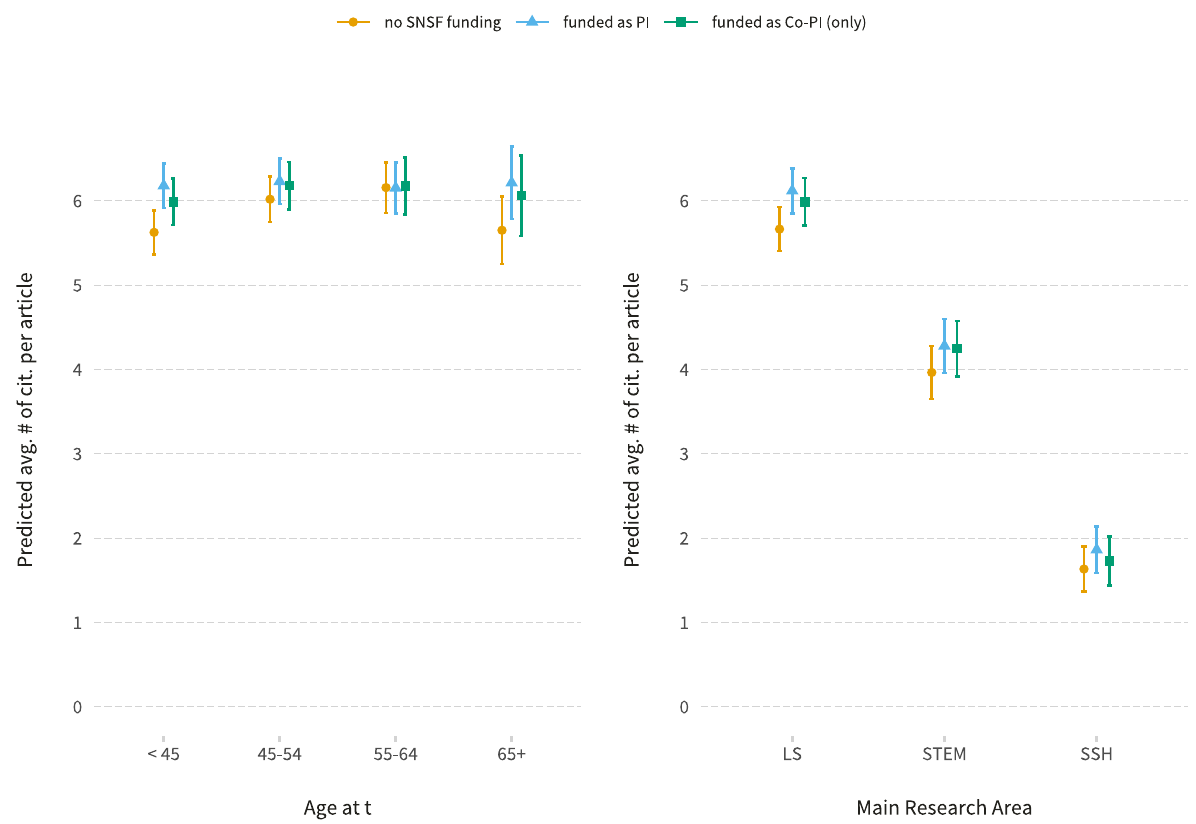
Fig. 3 Predicted yearly average number of citations per article depending on whether or not the researchers were treated or not, given the researcher ’ s age group (left) and the research fi eld (right). For the predictions the baseline confounding variables were fi xed to Year 2010 – 14, Male, Evaluation Score Score AB-A, University, LS in the age interaction model and age lower to 45 for the fi eld interaction model. A signi fi cant positive percentage change of 10% for the youngest age group among PIs (<45) compared to no SNSF funding can be observed for the average number of citations. The remaining changes in citation number are not signi fi cant. Then, the effect of funding is largest for SSH researchers (15% more citations per article as PI compared to unfunded researchers). The effect in LS ( + 6%) and STEM ( + 8%) is less prominent. Note that the intervals however all